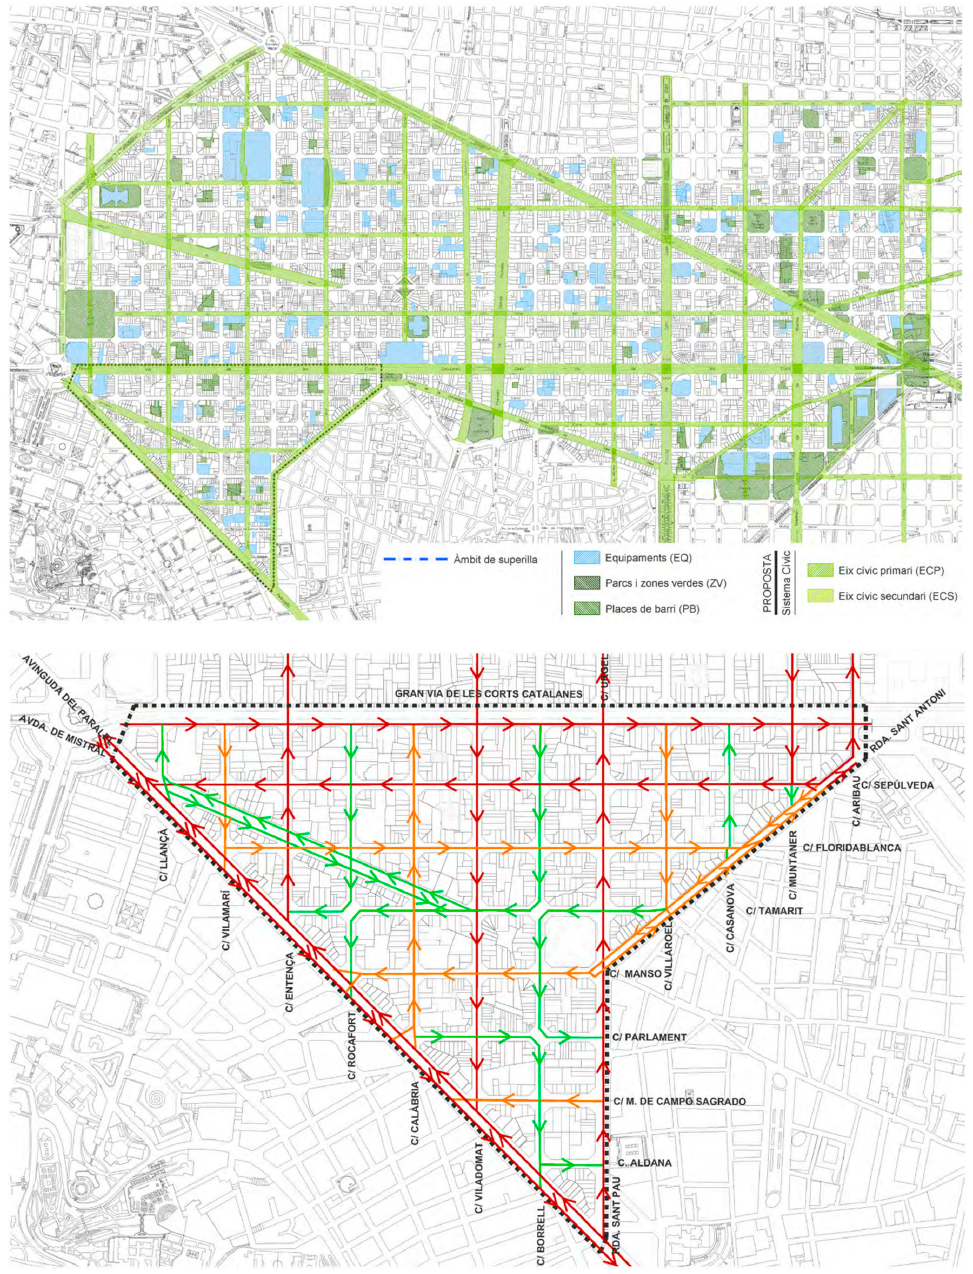
Figure 9. Implementation of the superblocks in the Sant Antoni neighborhood of L’Eixample district of Barcelona. ( Top ) Proposed system of civic axes (streets highlighted in green) for the entire L’Eixample district. ( Bottom ) Organization of motorized traffic directions, planned for higher (red lines), medium (orange lines), and lower (green lines) speeds and flows. At the intersection of civic axes (green lines) motorized traffic does not have longitudinal continuity and must turn. Source: Ajuntament de Barcelona [80].